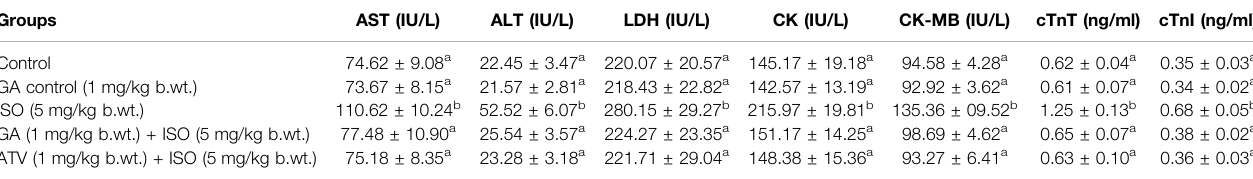
TABLE 1 | Effect of GA on AST, ALT, LDH, CK, CK-MB, cTnT and cTnI in the serum of control and ISO-induced rats.